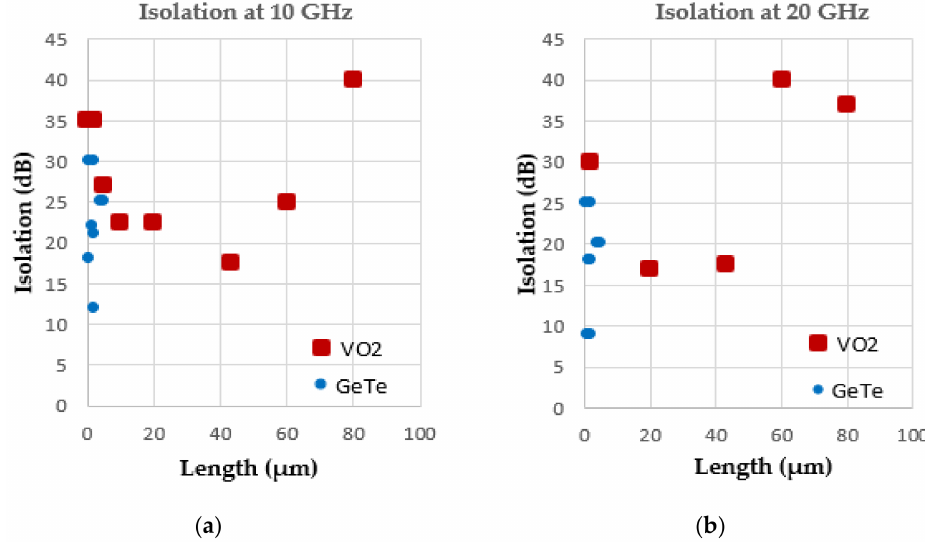
Figure 17. Isolation losses associated with each reported length of the device. ( a ) Isolation at 10 GHz; ( b ) Isolation at 20